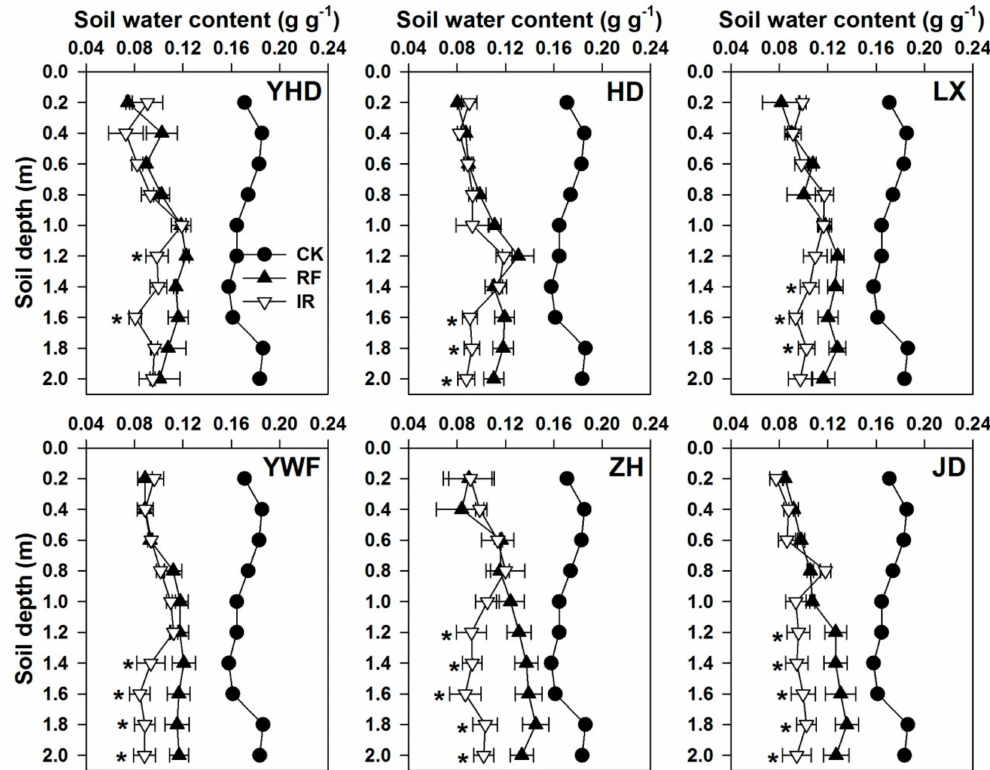
Figure 3. The soil profile of gravimetric soil water content (g g − 1 ) at 0.2 m increments in the upper 2 m of the soil profile of six soybean genotypes (four landraces: Yuanhuangdou (YHD), Huangsedadou (HD), Longxixiaohuangpi (LX) and Yiwofeng (YWF) and two recent cultivars: Jindou 19 (JD) and Zhonghuang 30 (ZH)) before sowing (CK) and at maturity under two water regimes (rainfed (RF): no water applied during flowering and irrigated (IR): 40 mm water applied during flowering) in the field experiment in 2012. The bars indicate one standard error of the mean ( n = 3). The * indicates that the SWC was significantly di ff erent ( p = 0.05) between the IR and RF at the same soil